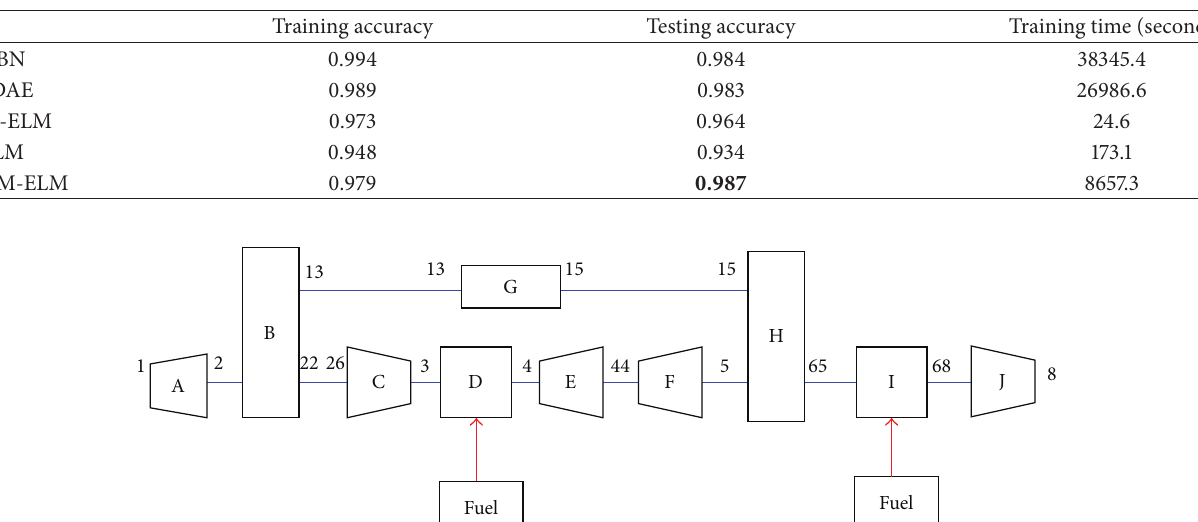
Table 1: Performance of all methods on MNIST.